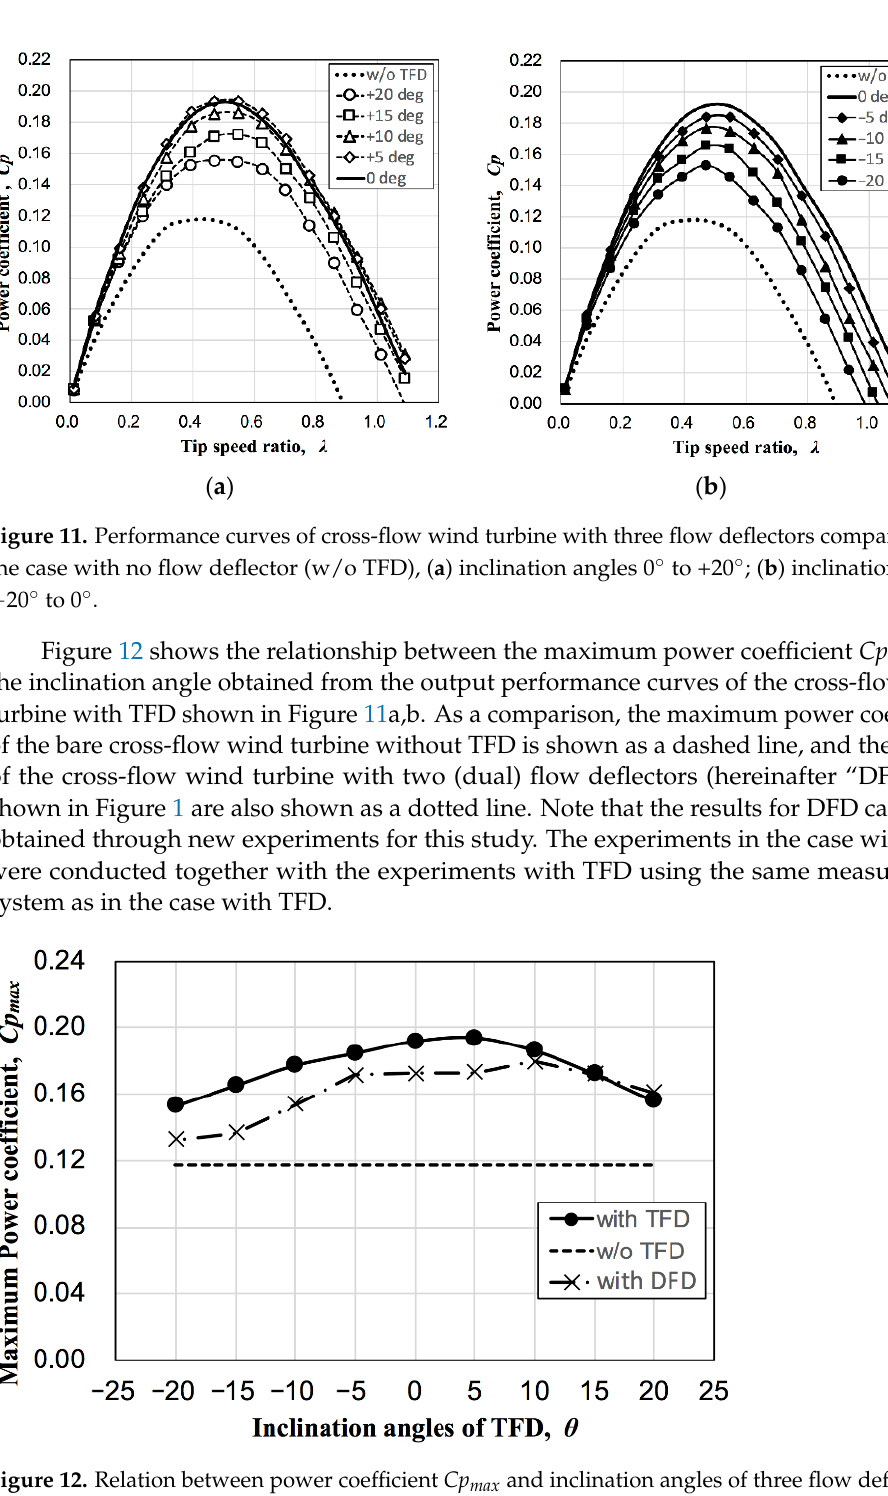
Figure 12. Relation between power coefficient Cp max and inclination angles of three flow deflectors θ by output performance test experiment.